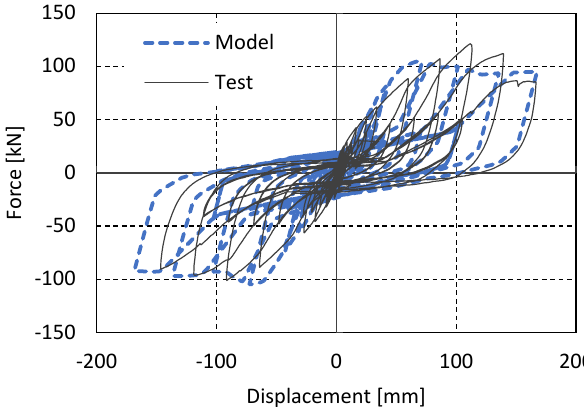
Figure 4. Shear wall model validation with test data.